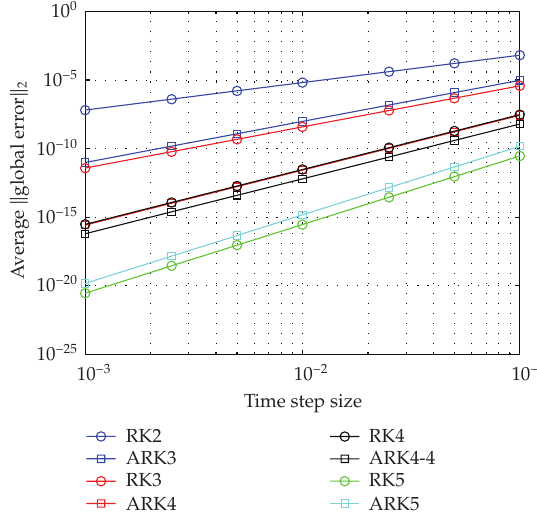
Figure 8: Accuracy plot for IVP-7 (cid:4) see caption of Figure 2 (cid:5)